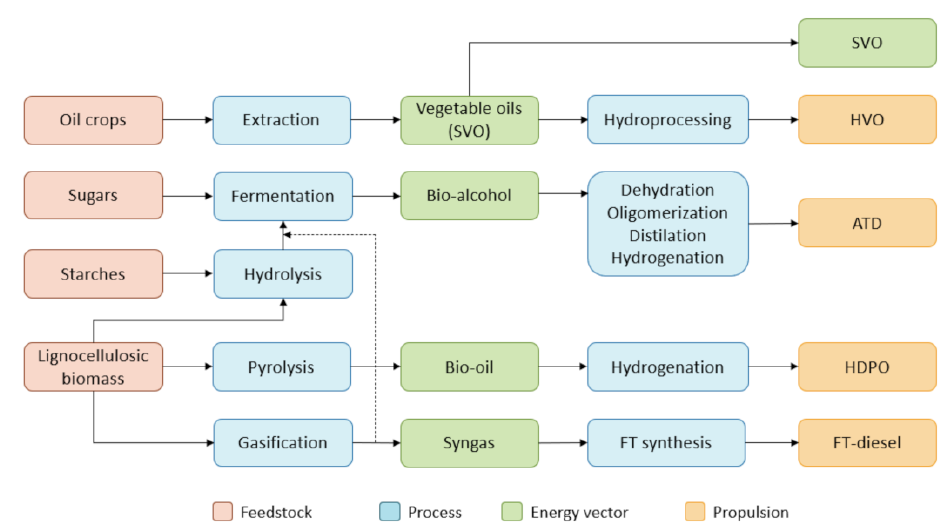
Figure 4. Fuel production pathways considered for biobunker production.